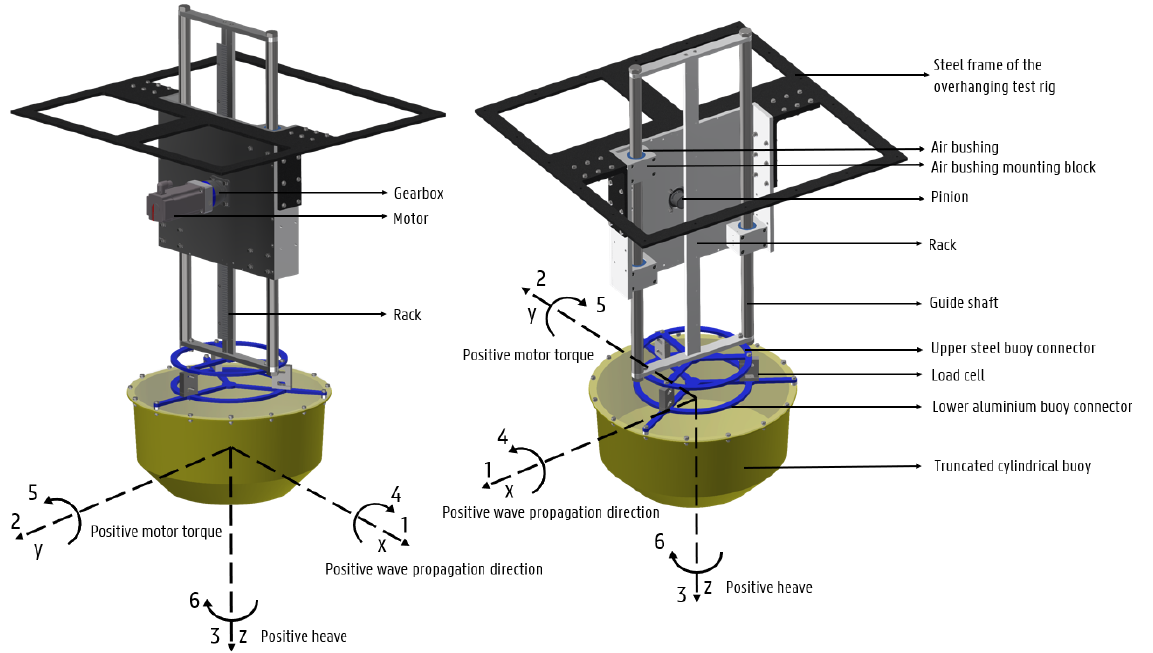
Figure 19. Rendering of the “WECfarm” WEC, made with Autodesk Inventor (Autodesk, San Rafael, CA,